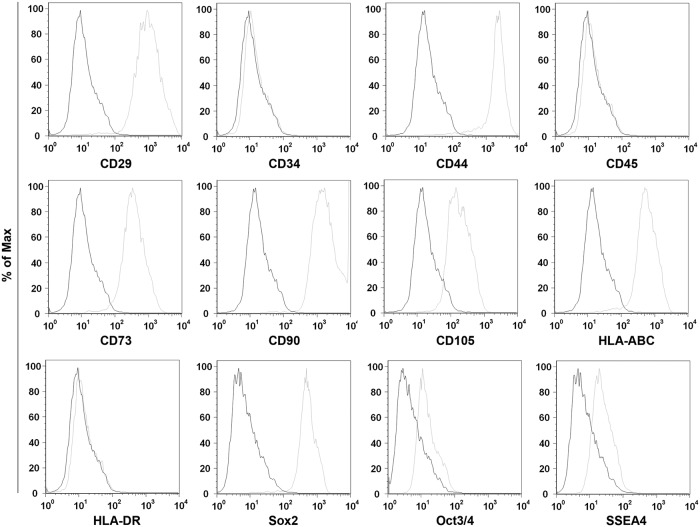
Cytofluorimetric analysis of the WJ cell culture.The histograms show the cytofluorimetric analysis of the WJ cell culture, surface and intracellular antigens expression profile: CD29, CD34, CD44, CD45, CD73, CD90, CD105, OCT3/4, SSEA4 and Sox2. Gray histograms represent cells stained with the expression markers; black histograms are the respective IgG isotype control.